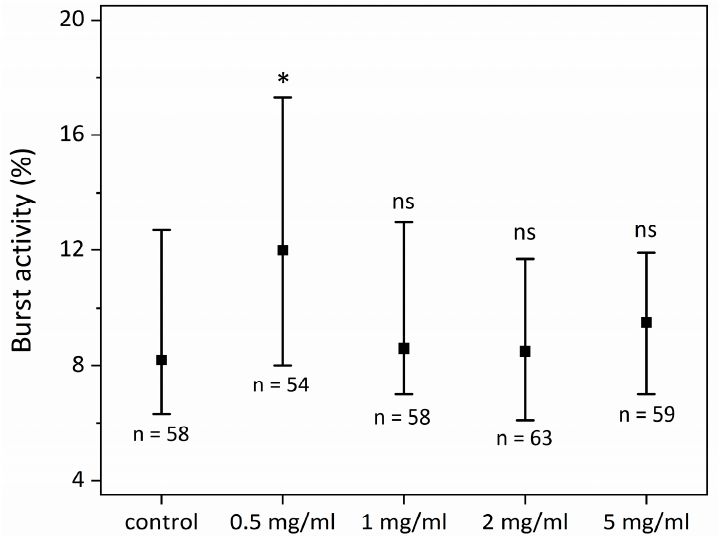
Figure 1. Comparison of zebra fi sh larva motility after SCI exposure, * p < 0.01 compared to the con- trol group, ns—not signi fi cant. control group, ns—not